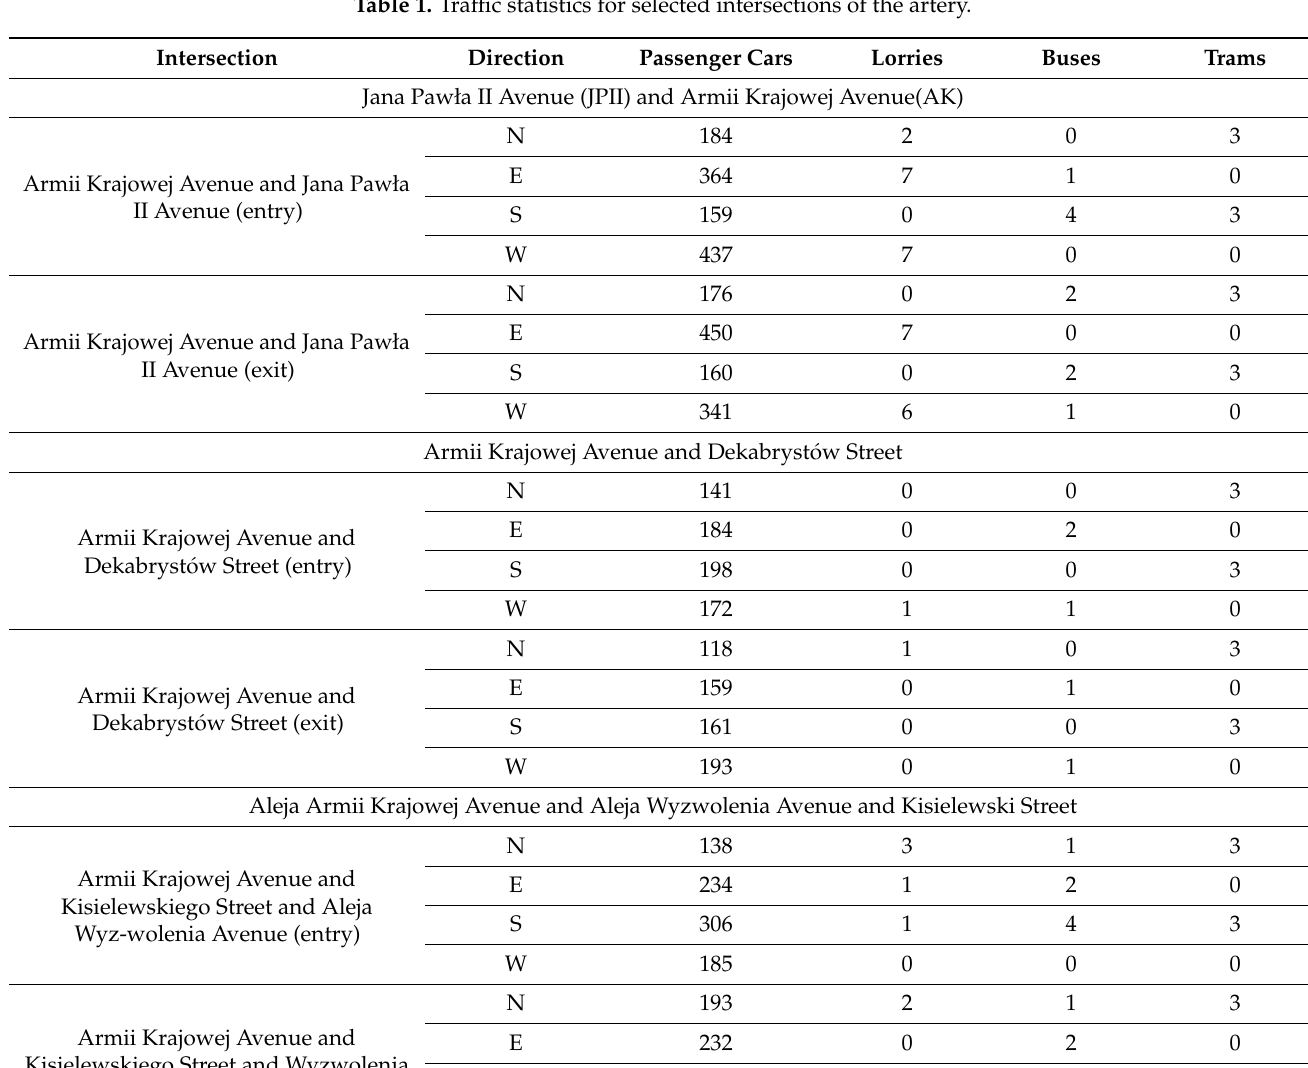
Table 1. Traffic statistics for selected intersections of the artery. Intersection